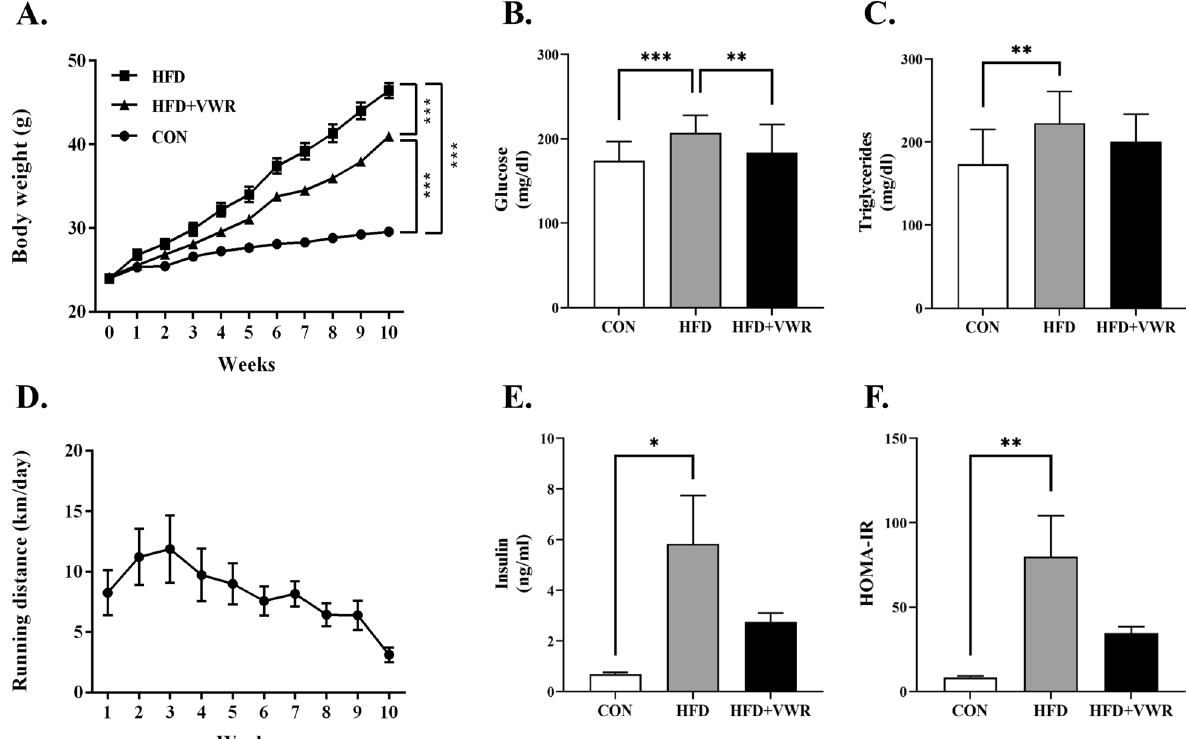
Fig. 1 Effects of HFD and VWR exercise on weight A , blood glucose B , triglycerides C , running distance D , insulin E , and HOMA-IR F . Values are shown as mean SEM. *P < .05, **P < .01, ***P < ±